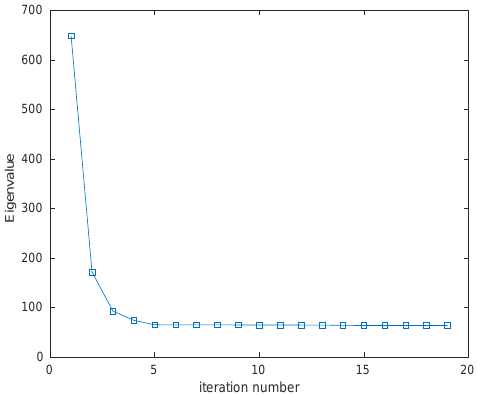
Figure 9. The total eigenvalue of objective function with the iteration